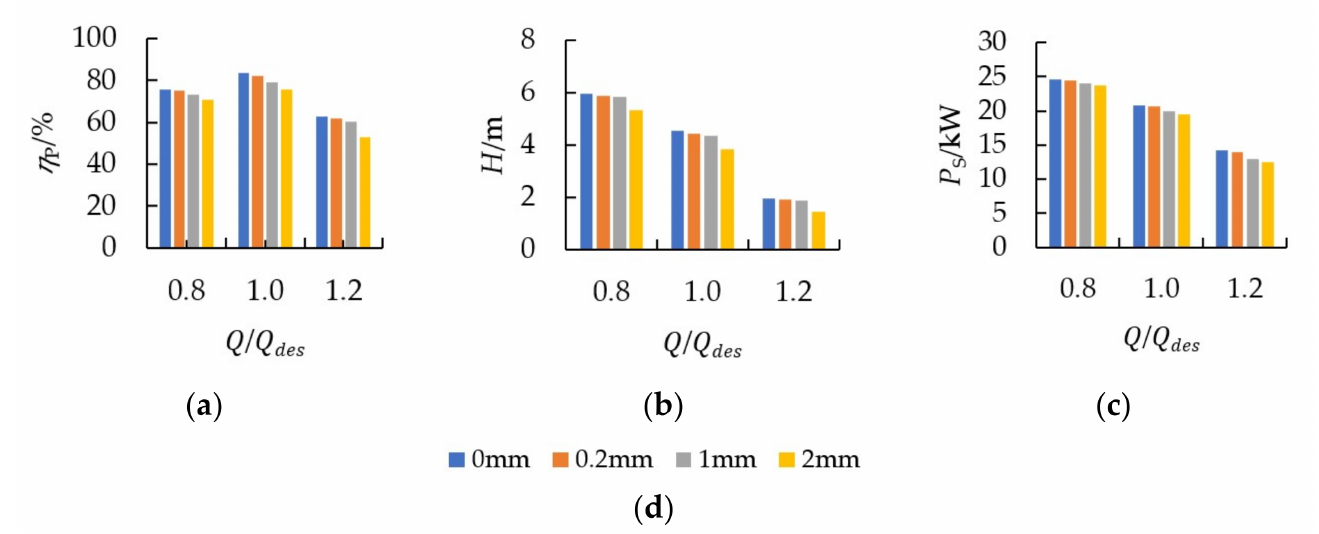
Figure 5. Comparison of ( a ) efficiency; ( b ) head; ( c ) shaft power under different tip clearances in pump condition; ( d )